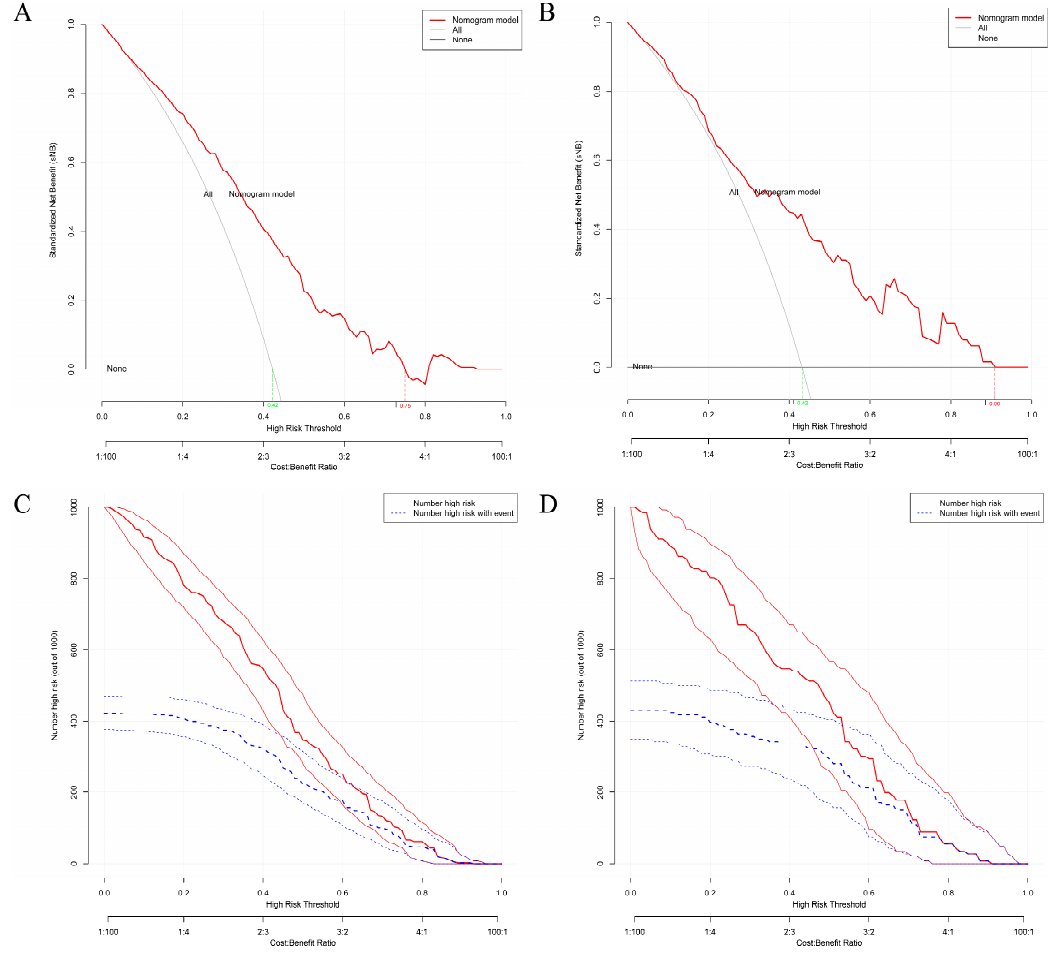
Figure 6. Validation of clinical benefits and clinical impacts of nomogram prediction models. ( A ) The DCA curve of the training group, the “Nomogram model” showed clinical benefit compared to “ALL” at a determination threshold of 0–0.75. ( B ) The DCA curve of the validation group, the “Nomogram model” showed clinical benefit compared to “ALL” at a determination threshold of 0–0.90. ( A , B ) The red line (Nomogram model) represented the overall benefit if screening was performed based on the Nomogram model clinical prediction model developed for this study. Clinical subjects with true osteoporosis who were screened (true positives) were considered to have received a clinical benefit (because early detection and diagnosis and treatment were possible after screening). Patients who did not have osteoporosis but were screened for osteoporosis (false positives) were considered to have incurred costs but did not receive clinical benefit. The trade-off between these overall costs and clinical benefits was the study objective of the DCA curve. The gray line (ALL) represented the overall benefit of considering all clinical subjects to be osteoporotic. This also yielded some clinical benefit and unnecessary cost. The gray-black line (None) represented the assumption that all clinical subjects were not osteoporotic and thus no action was taken. No cost was incurred, but there was no clinical benefit either. The horizontal coordinate represented the threshold at which clinical subjects were judged to be positive (high risk threshold, ranging from 0–1 for the “Nomogram model” and “ALL”, respectively). The vertical coordinate represented the net clinical benefit after normalization (standardized net benefit, sNB). At the same threshold, the sNB of “Nomogram model” and “ALL” were compared, and if sNB > 0, a clinical benefit was considered at this point. ( C ) Clinical impact curve of the training group. ( D ) Clinical impact curve of the validation group. ( C , D ) At the same horizontal coordinate (high risk threshold), the vertical coordinate (Number high risk (out of 1000)) of the red line (Number high risk) and the blue line (Number high risk with event) were compared, and if the vertical coordinate of the red line was higher than the blue line, it was considered clinically significant at that